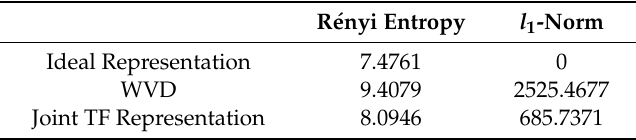
Table 1. Performance